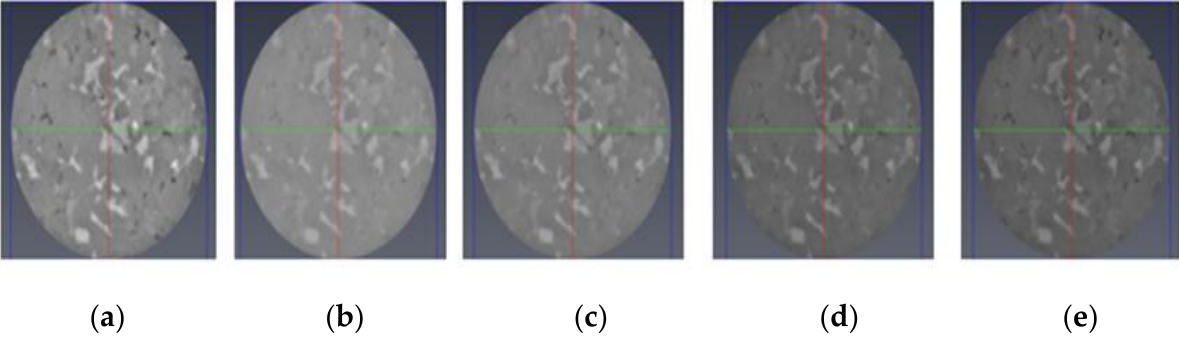
Figure 18. CT scanning results of the Y56 – 19 core under different displacement states. ( a ) Dry rock sample. ( b ) Saturated crude oil. ( c ) First water flooding. ( d ) CO 2 flooding. ( e ) Second water flood- ing.